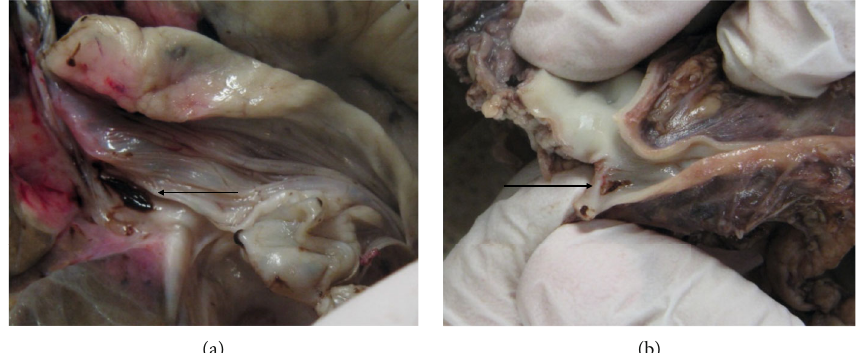
Figure 3: Pig #4. RA gross anatomical evaluation after RDN. (a) RA thrombosis. (b) RA dissection. RA: renal artery; RDN: renal artery denervation.